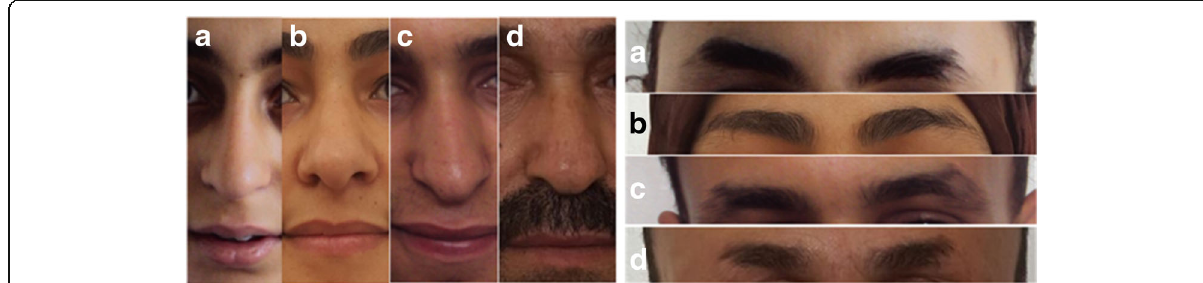
Fig. 2 Typical dysmorphological features of TRPS III in the family members showing thick eyebrows with lateral rarefaction, characteristic pear- shaped nose, long philtrum and thin upper lip. a - Proband, b - Sister, c - Brother, d - Father